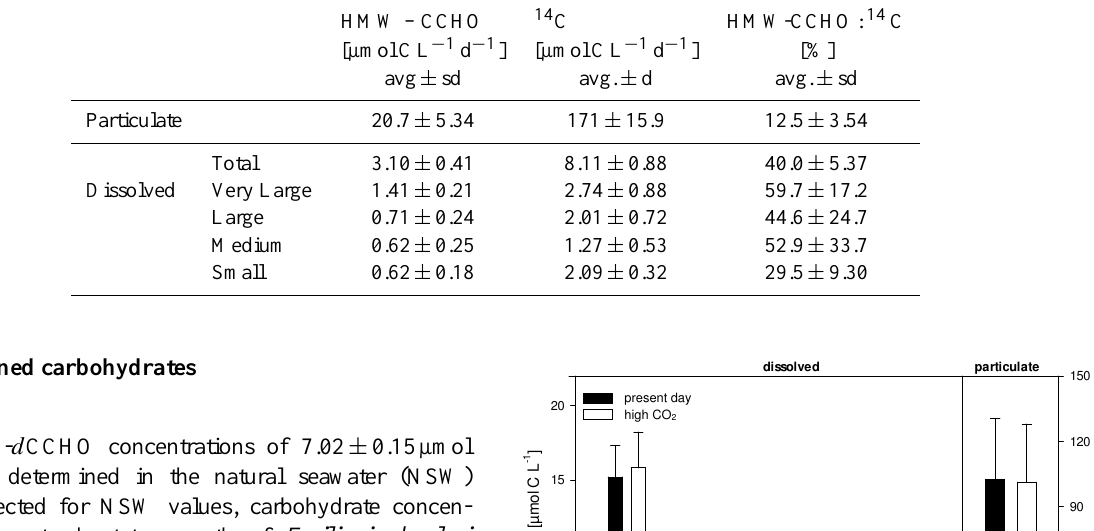
Table 2. Size class resolved production rates of high molecular weight ( > 1kDa) carbohydrates (HMW-CCHO) and of fresh organic carbon ( 14 C) during the chemostat experiment, as well as contribution of carbon contained in HMW-CCHO to primary production ( 14 C) in particu- late matter and in different size fractions of dissolved organic carbon . Values represent averages ± standard deviation of replicate samplings and both treatments, n = 6.